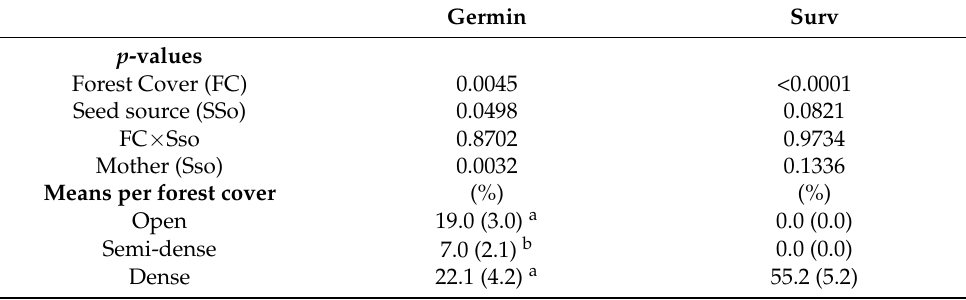
Table 2. p -values from the analysis of variance and means per seed source and habitat type (plus stan- dard errors) for germination (Germin), survival (Surv) on C. alba in the field experiment. Seed sources were Cuesta La Dormida (CD), Antumapu (AN), Cantillana (CA) and Cayumanque (CY). Different letters within a column indicate significant differences according to Tukey’s test. Germination was determined by counting the seeds with visible radicles and expressing them relative to the total seeds sowed, whereas survival was expressed as the surviving seedlings relative to the germinated seeds. Germin Surv p -values Forest Cover (FC) 0.0045 <0.0001 Seed source (SSo) 0.0498 0.0821 FC × Sso 0.8702 0.9734 Mother (Sso) 0.0032 Means per forest